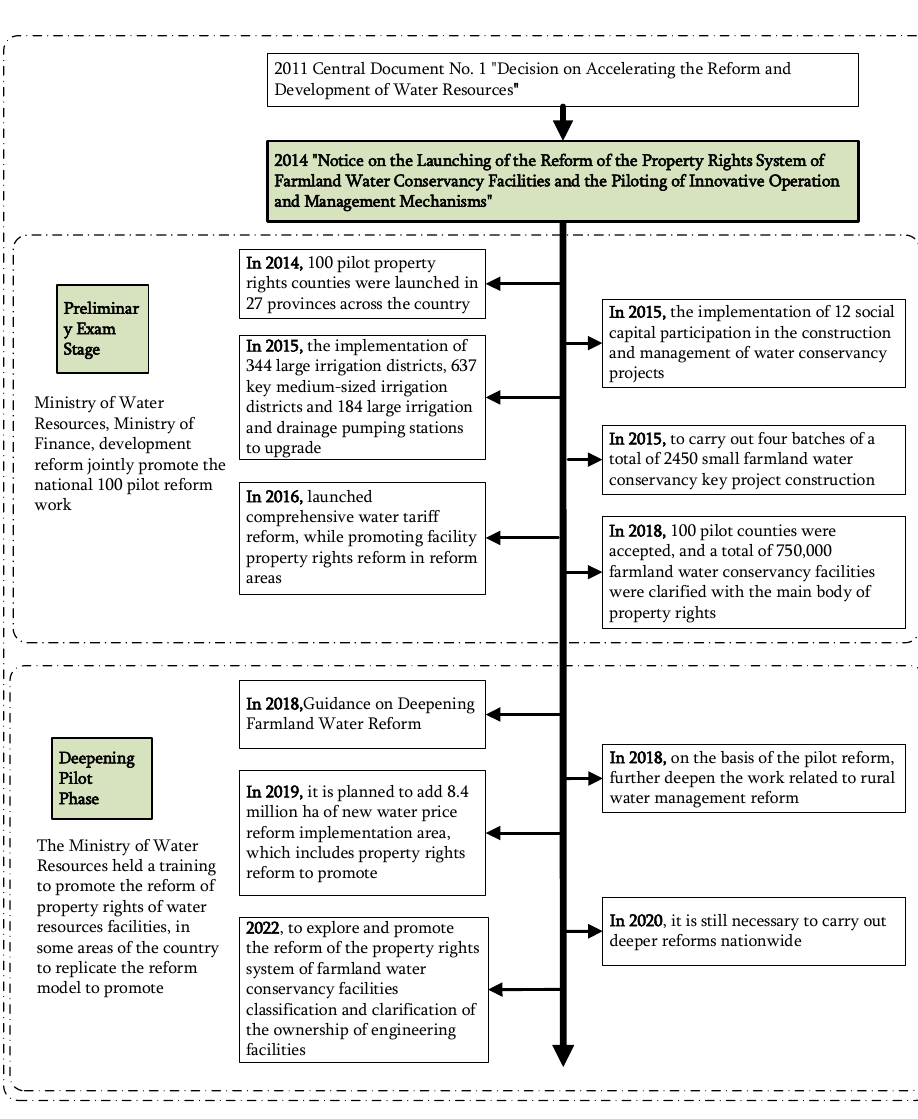
Figure 1. Organizational approach used to promote changes to China’s policies on farmland water property rights as a means to improve agricultural water conservation.